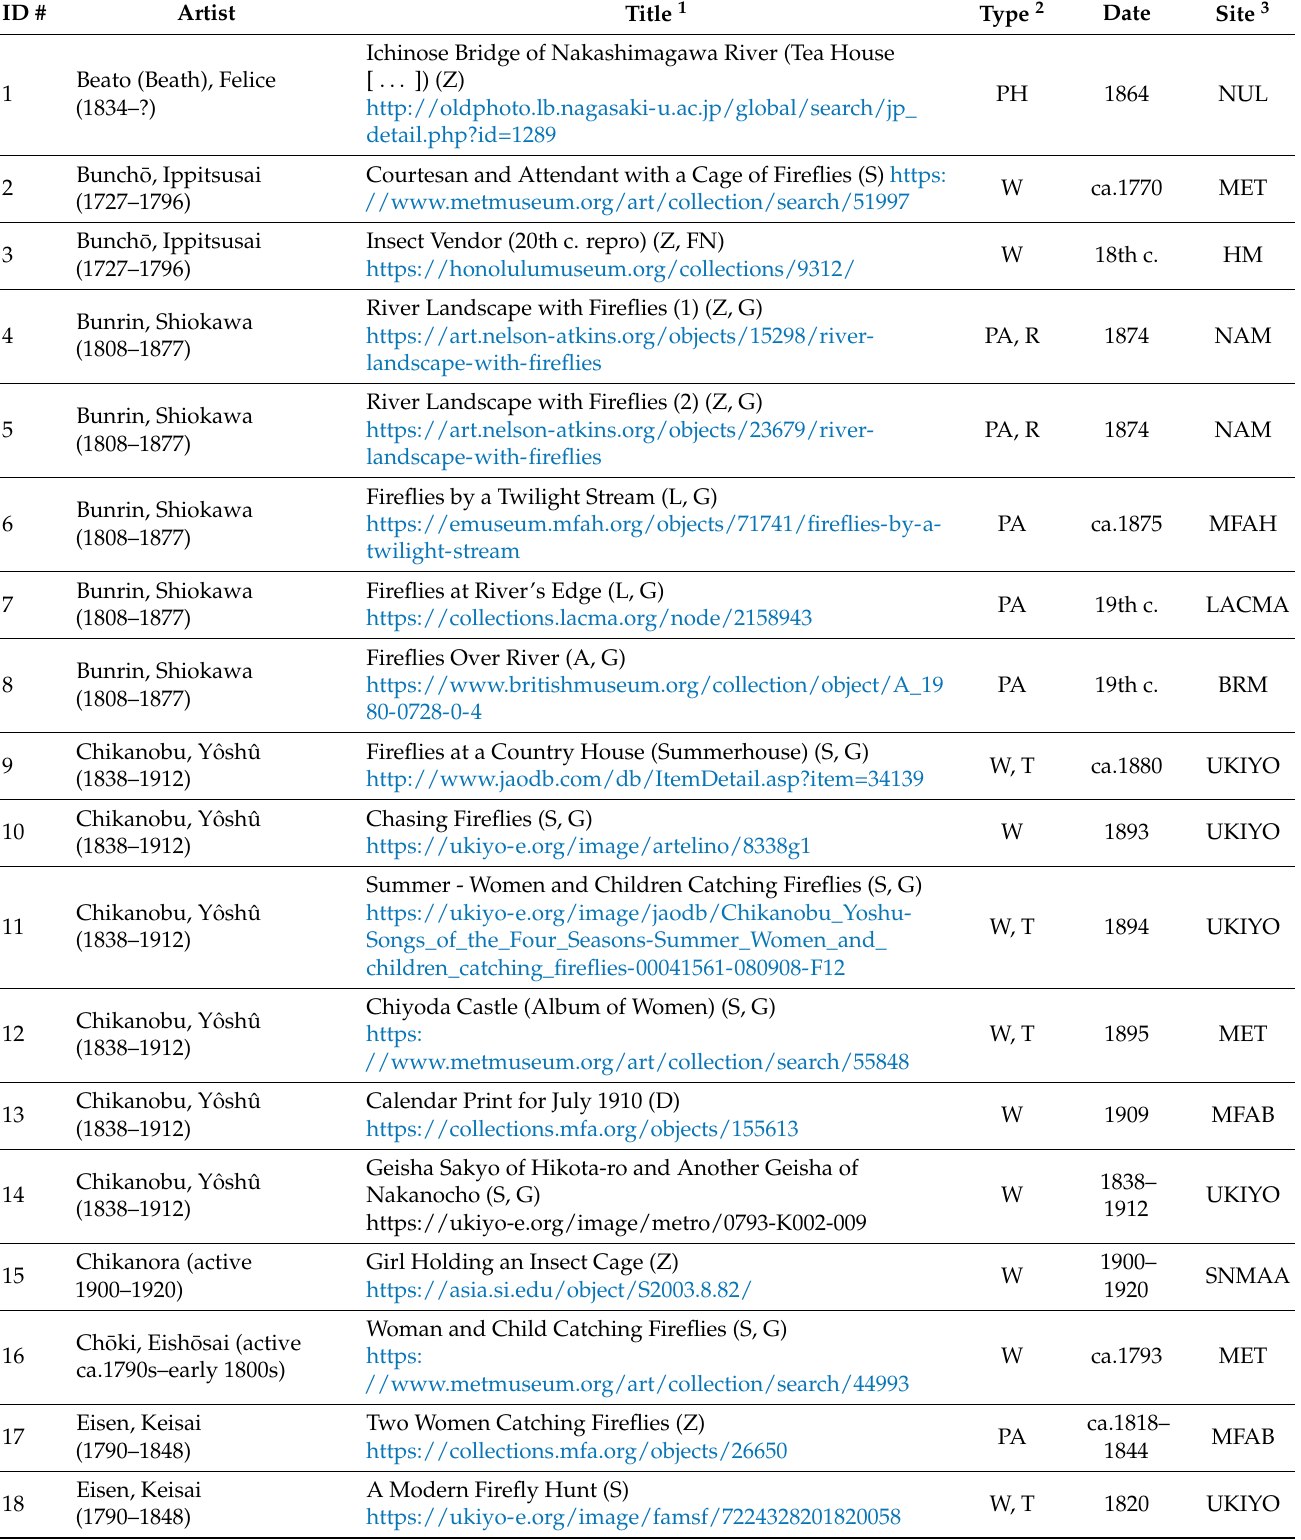
Table A1. List of artwork (accessed multiple times from 4 January 2022 to 22 August